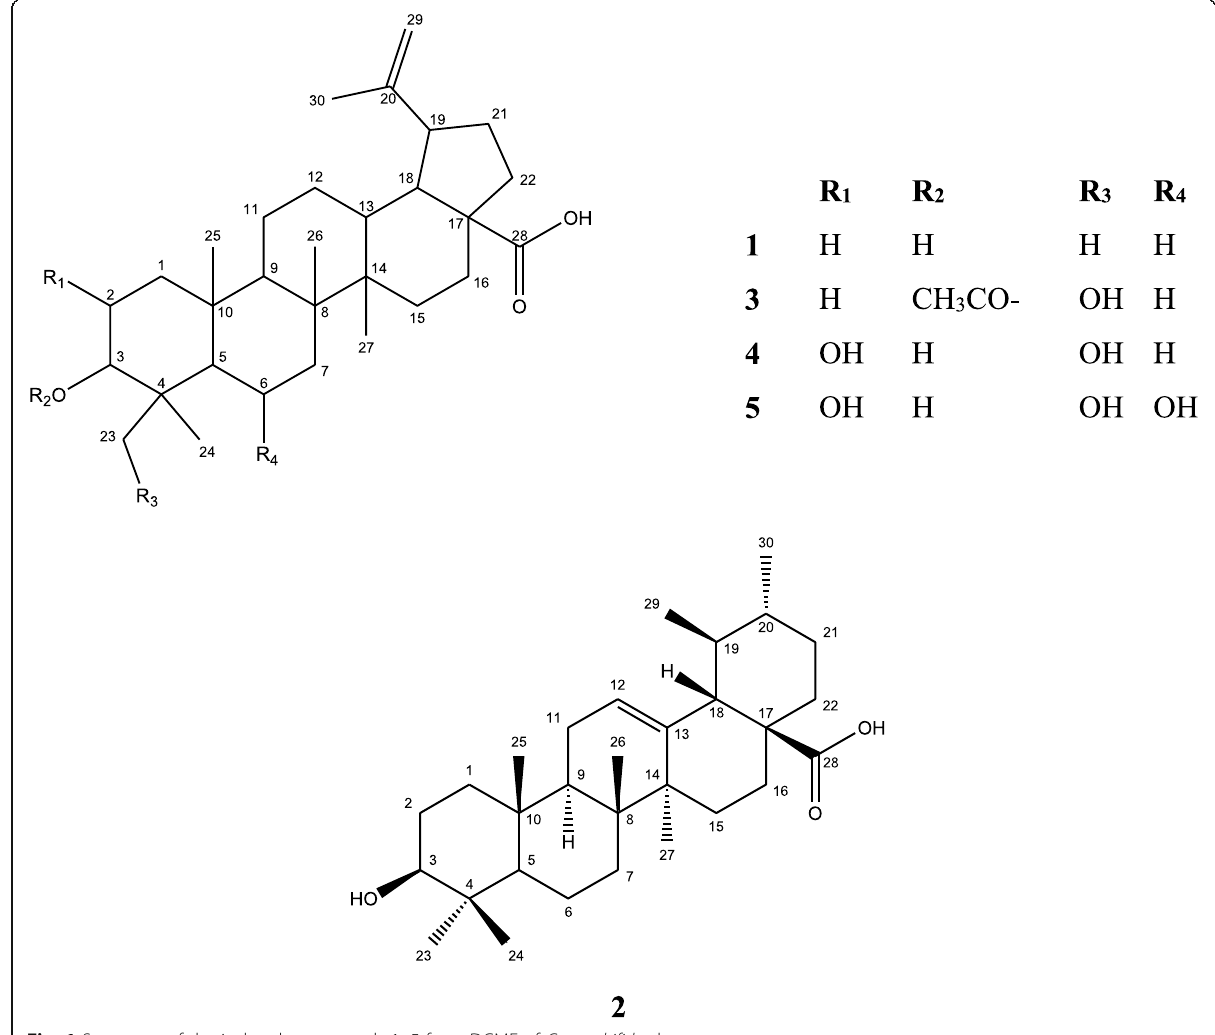
Fig. 1 Structures of the isolated compounds 1 – 5 from DCMF of C. quadrifidus